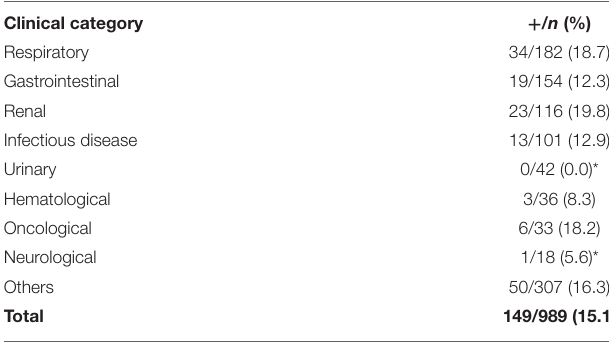
TABLE 3 | Seroprevalences for D. immitis in cats in Spain based on presence and nature of clinical